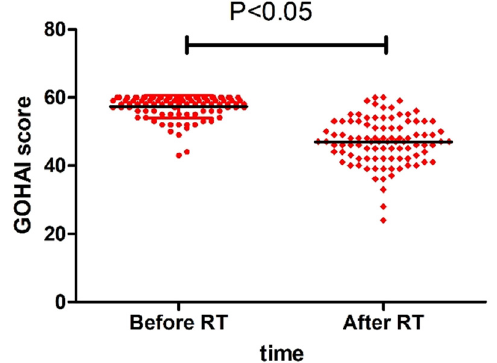
Figure 2: Changes of GOHAI in NPC patients before and after RT ( P < 0.05 ) .